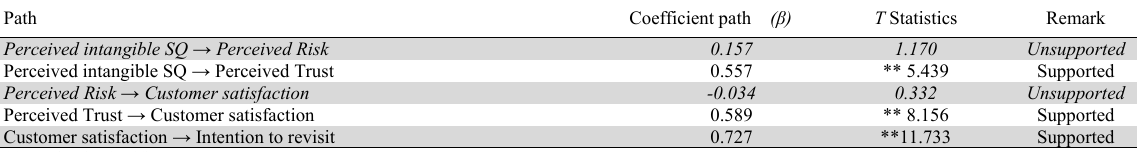
The summary of the regression analysis